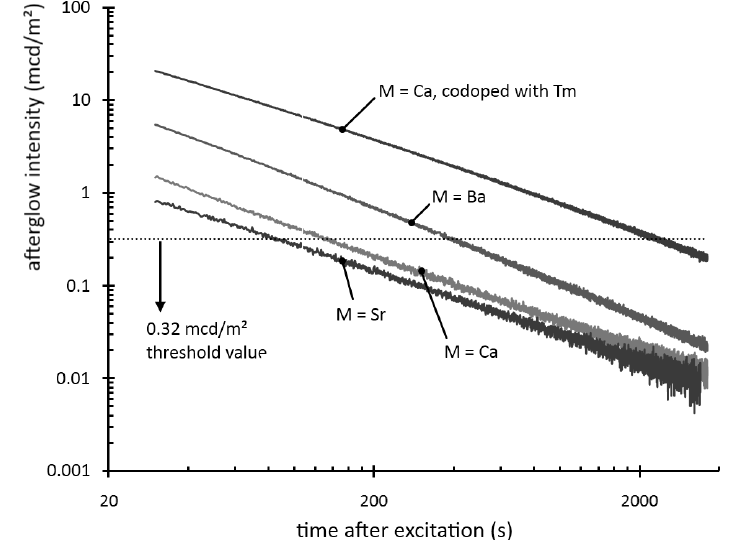
Figure 2. Decay of the afterglow intensity after 1 min excitation with a Xe arc lamp at 1000